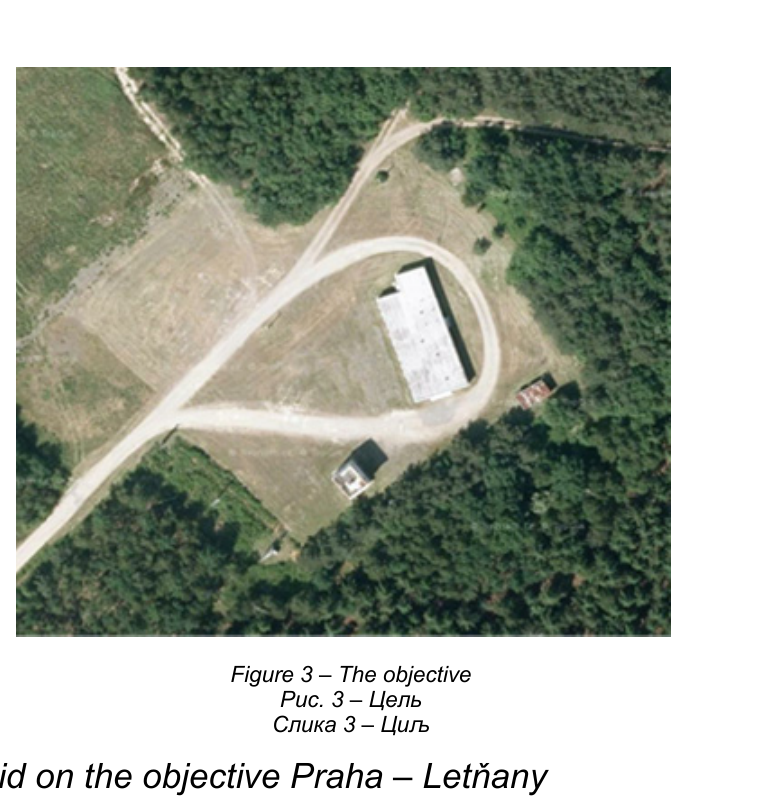
Figure 3 – The objective Рис . 3 – Цель Слика 3 –